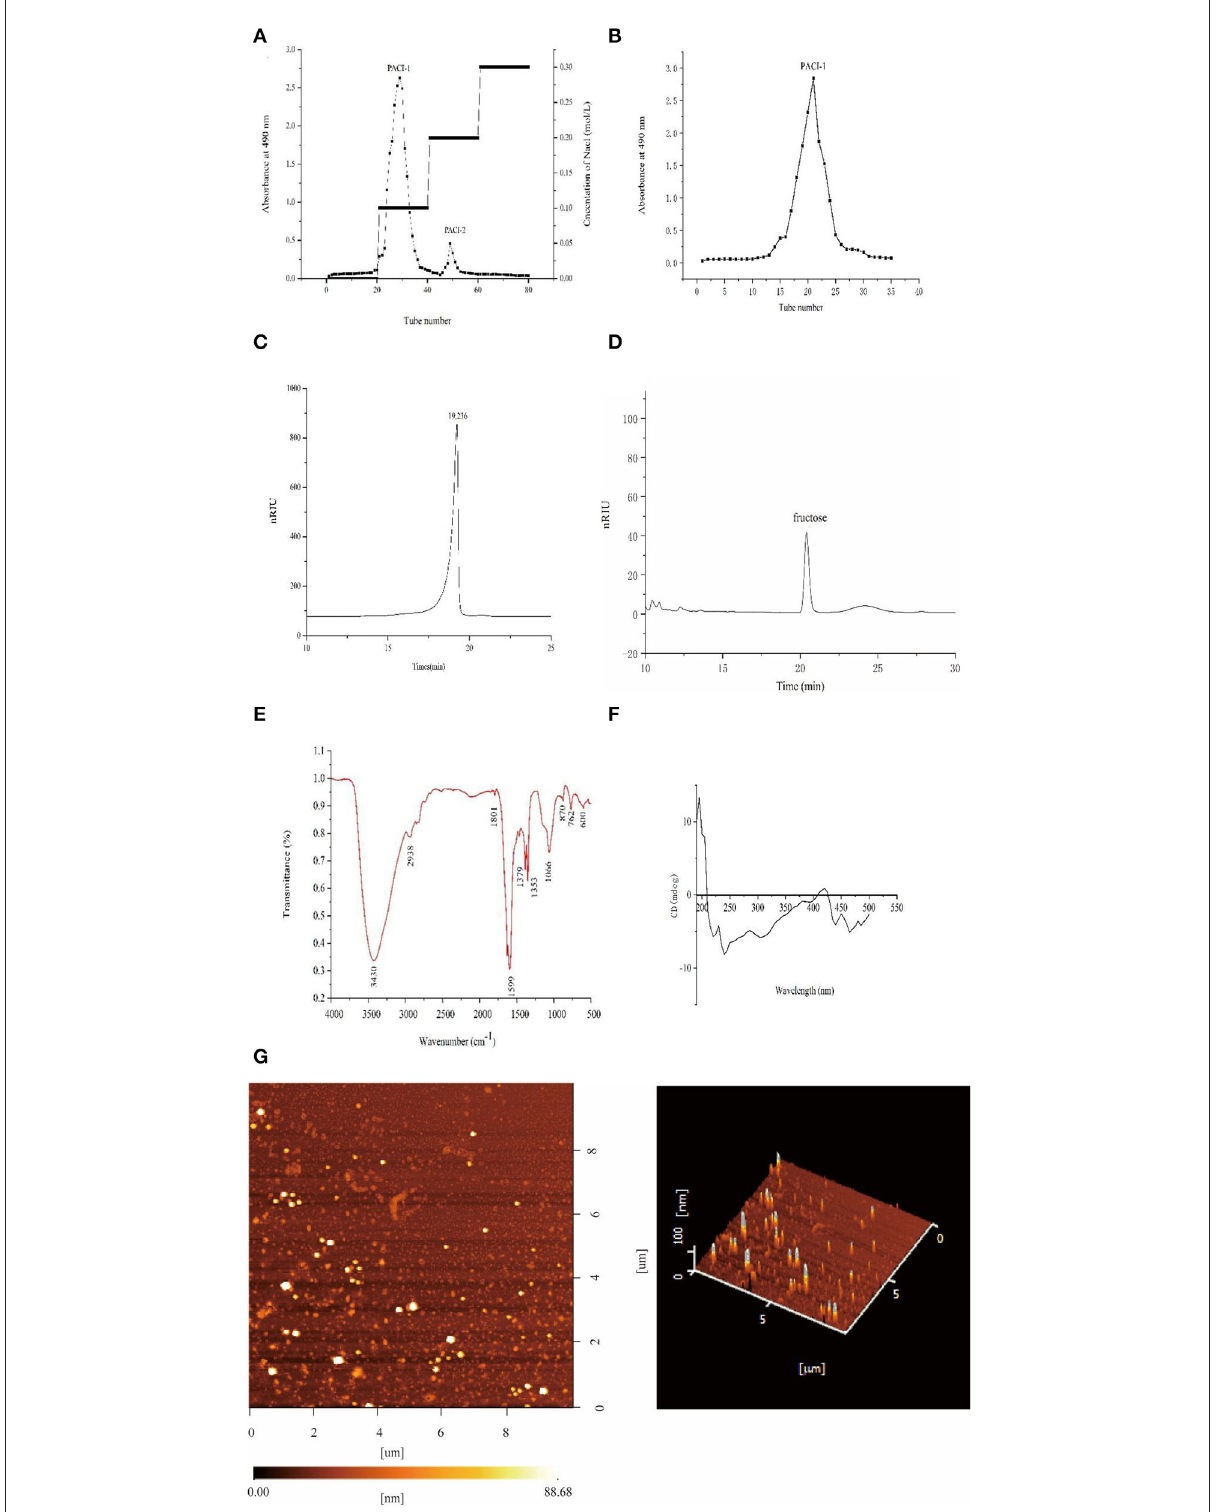
FIGURE5 Structural analysis of PACI-1. DEAE-52 anion exchange elution curve (A) . G-100 gel elution curve (B) . High-performance liquid chromatography spectrum (C) . Monosaccharide composition (D) . IR spectrum (E) . CD spectrum (F) . AFM images of PACI-1 (G) .